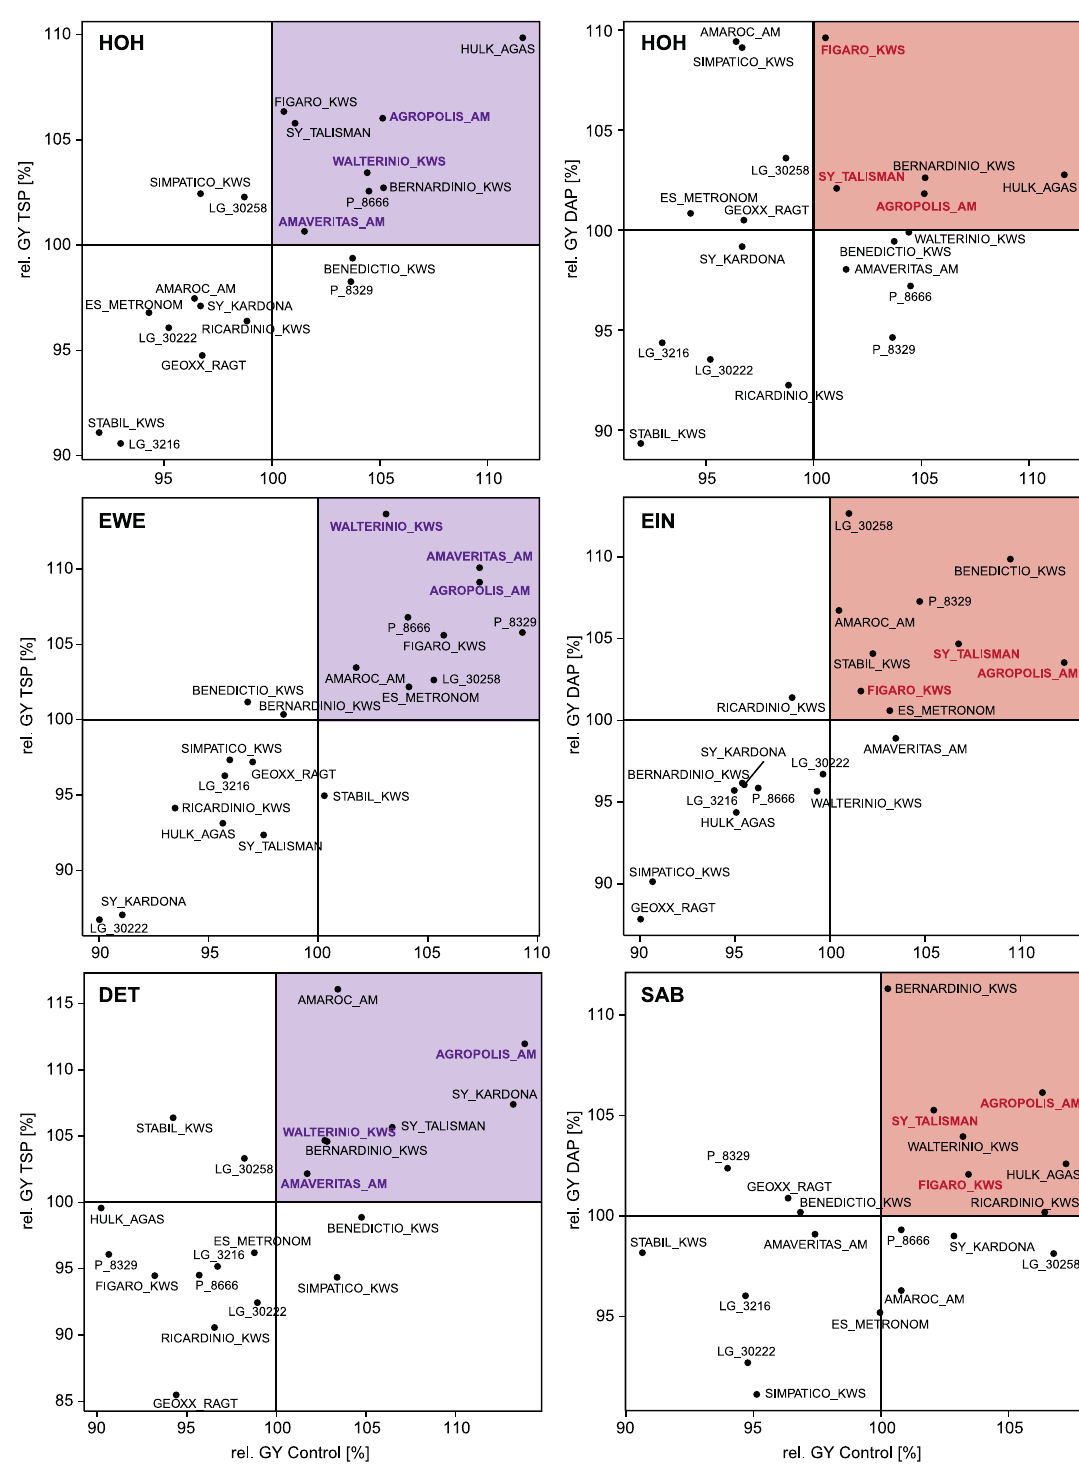
Fig 4. Scatterplots of each starter fertilizer-location combination. Relative grain yield (rel. GY [%]) in the control vs. triple superphosphate (TSP, purple) or vs. diammonium phosphate (DAP, red), respectively. Quadrants are counted starting from the highlighted one as I (stably above- average-yielding P-utilizers) in an anti-clockwise manner to IV (II and IV indicate P-sensitivity). The varieties which in all three locations were located in Quadrant I are highlighted in bold and color. Locations are abbreviated as follows: Hohenheim (HOH), Eckartsweier (EWE), Dettingen (DET), Einbeck (EIN), and Saerbeck (SAB).